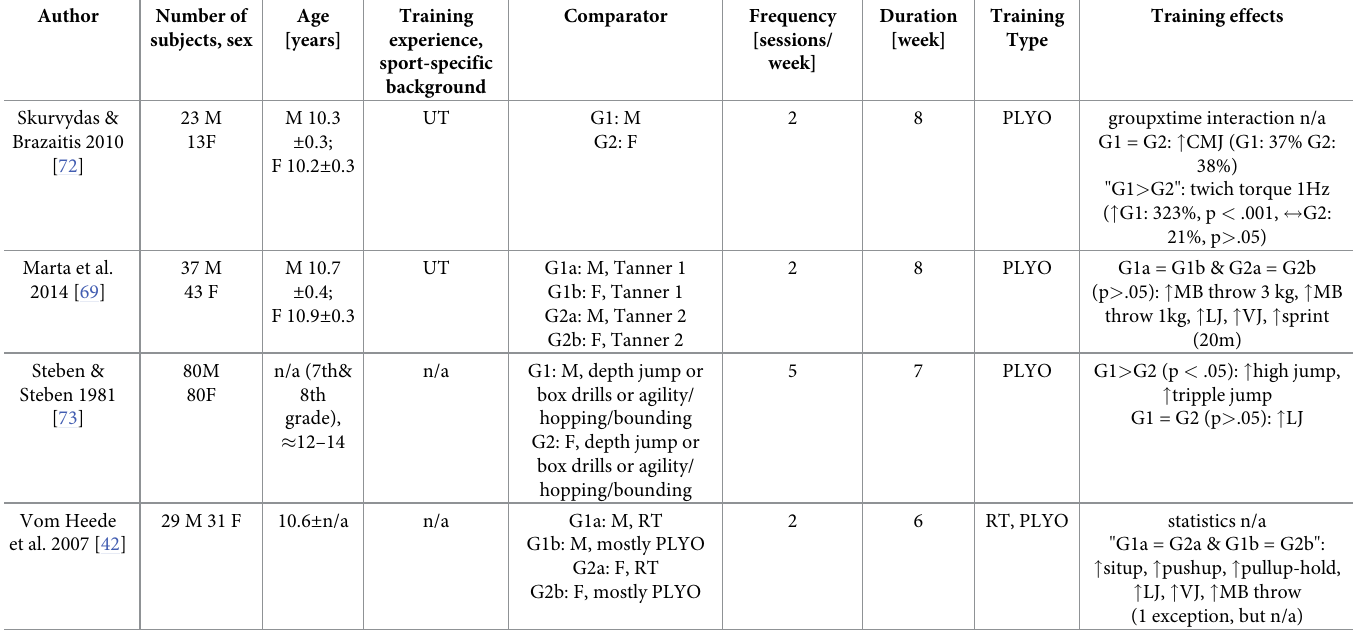
Table 9. Influence of the moderating variable ‘sex’ on plyometric training induced improvements in components of physical